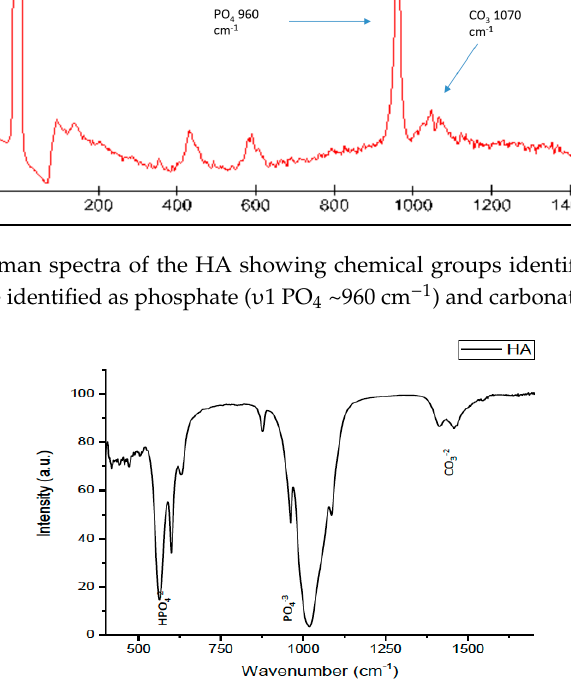
Figure 4. FTIR (Fourier transform infrared spectroscopy) Spectrum of HA nanoparticles, the two strong peaks at 56 and 1017 cm − 1 representing hydrogen phosphate (HPO 4 ) and phosphate (PO 4 ), respectively. The smaller peak at 1460 cm − 1 indicated carbonate (CO 3 ) .